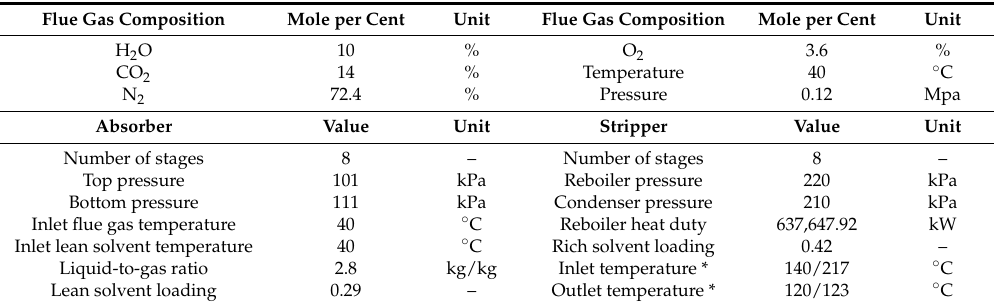
Table 4. Flue gas, absorber and stripper